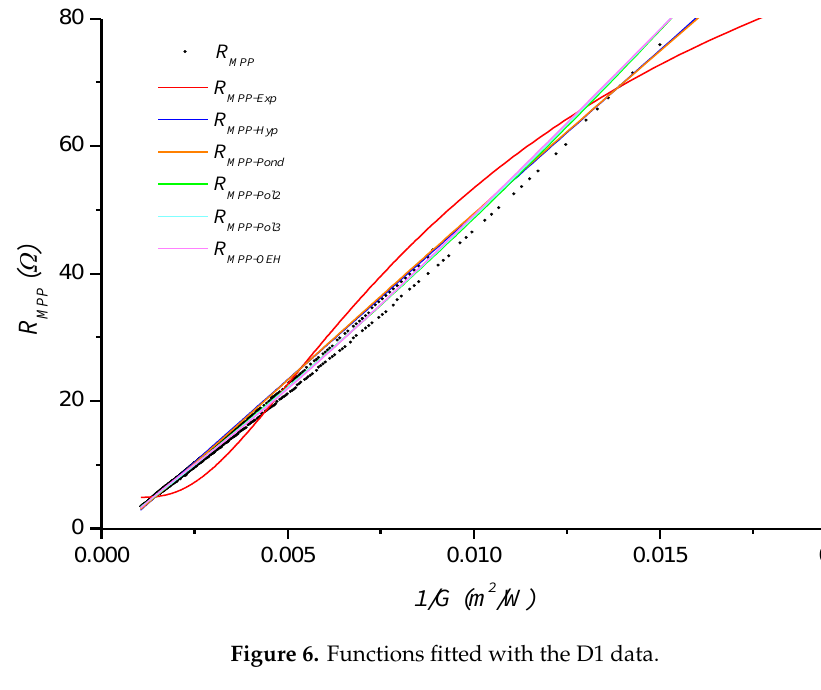
Figure 6. Functions fitted with the D1 data.